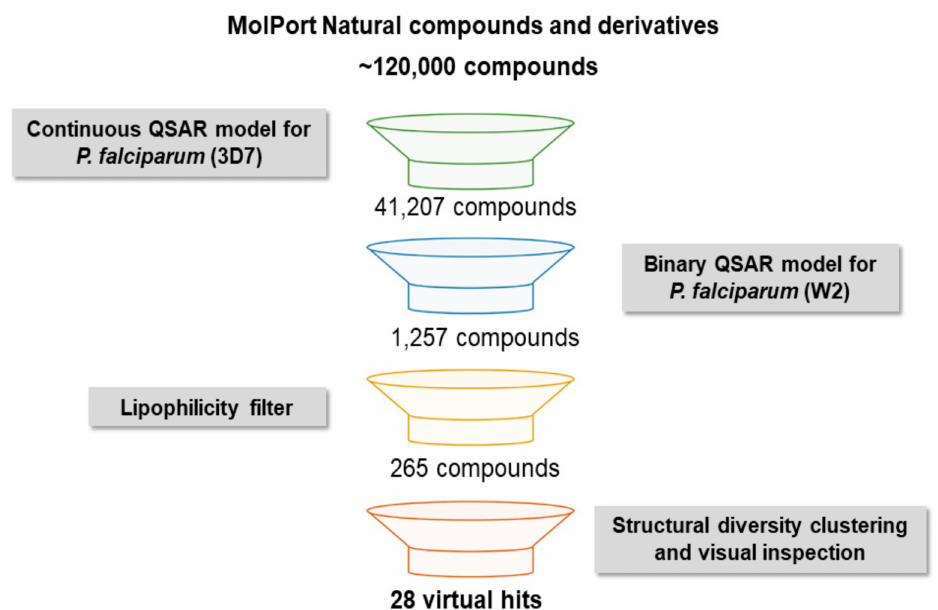
Figure 2. Virtual screening workflow for the identification of natural compounds and derivatives active against P. falciparum